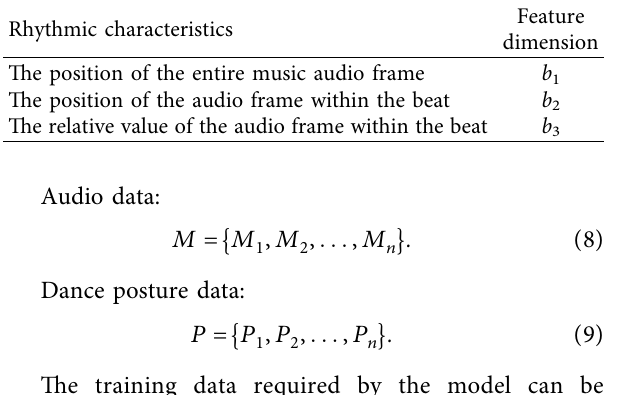
Table 2: Table of beats feature. Rhythmic characteristics